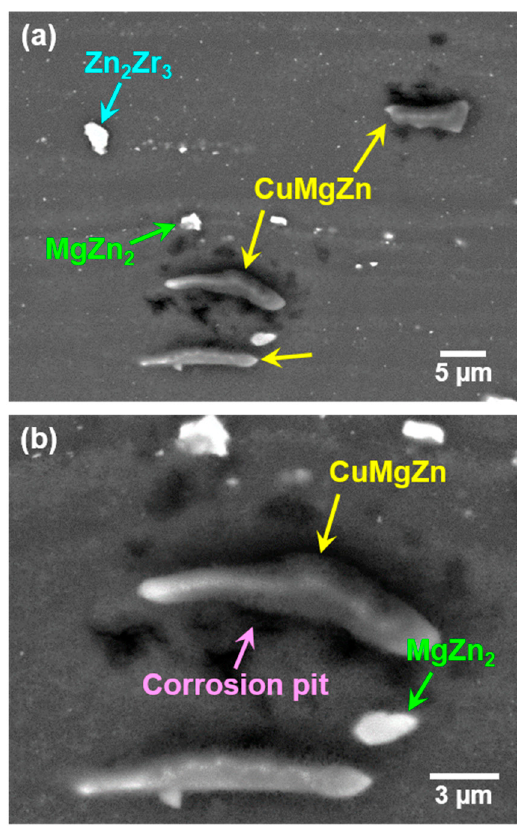
Figure 5. SEM micrographs showing the corroded surface of the ZKC601 alloy after immersion for 1 h in 0.6 M NaCl solution at 25 °C at relatively ( a ) low and ( b ) high magnifications.